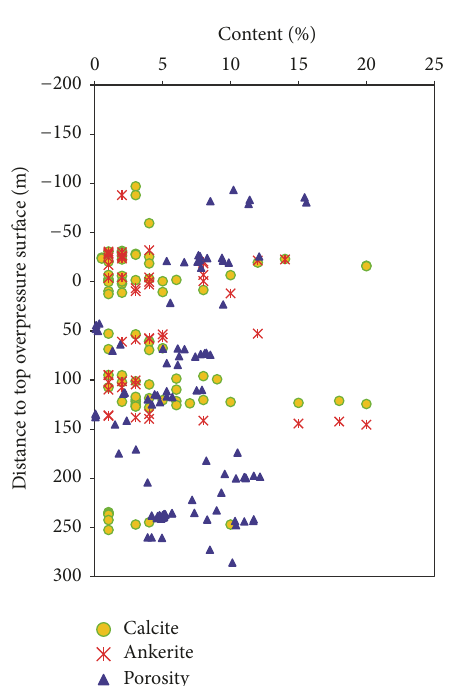
Figure 8: Relations between carbonate content, porosity, and distance to top overpressure surface of Block